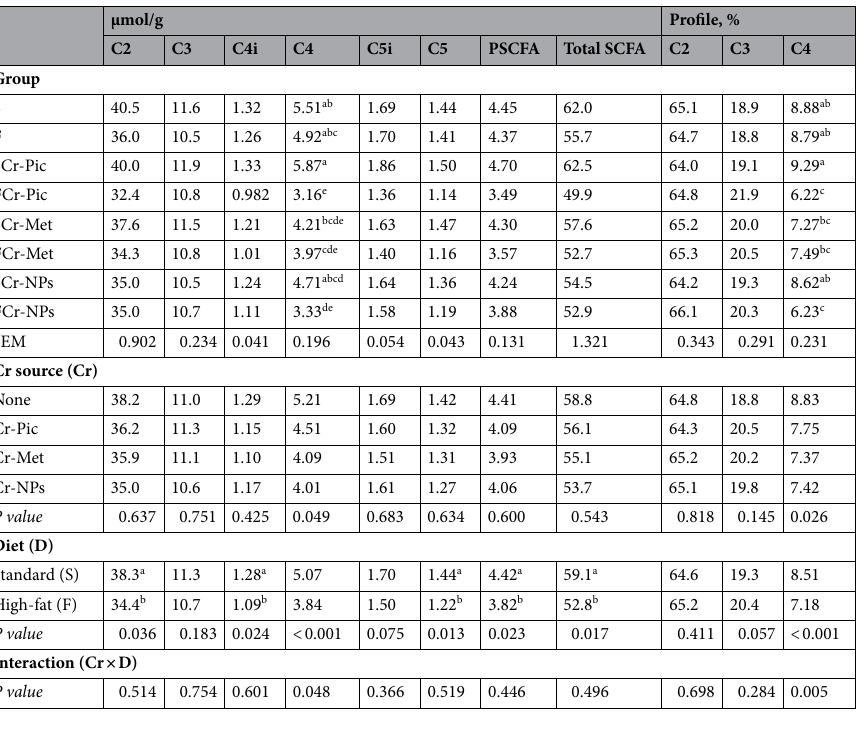
Table 6. Concentration and profile of short-chain fatty acids in the caecal digesta of rats fed experimental diets. S—Rats fed a standard diet; F—rats fed a high-fat, low-fibre diet; SCr-Pic—rats fed diet S supplemented with 0.3 mg Cr/kg BW from chromium(III) picolinate; FCr-Pic—rats fed diet F supplemented with 0.3 mg Cr/kg BW from chromium(III) picolinate; SCr-Met—rats fed diet S supplemented with 0.3 mg Cr/kg BW from chromium(III)-methionine; FCr-Met—rats fed diet F supplemented with 0.3 mg Cr/kg BW from chromium(III)-methionine; SCr-NPs—rats fed diet S supplemented with 0.3 mg Cr/kg BW from nano-sized chromium; FCr-NPs—rats fed diet F supplemented with 0.3 mg Cr/kg BW from nano-sized chromium. a,b,c,d,e Means within a column with different superscript letters are significantly different ( P < 0.05); differences between groups (S, F, SCr-Pic, FCr-Pic, SCr-Met, FCr-Met, SCr-NPs and FCr-NPs) are indicated with superscripts only in the case of a statistically significant interaction Cr × D ( p < 0.05). SEM—pooled standard error of mean (standard deviation for all rats divided by the square root of the number of rats, n = 56). SCFA— Short-chain fatty acids; PSCFA—putrefactive SCFA (the sum of iso-butyric, iso-valeric and valeric acids); acids: C2—acetic; C3—propionic; C4i—iso-butyric; C4—butyric; C5i—iso-valeric;